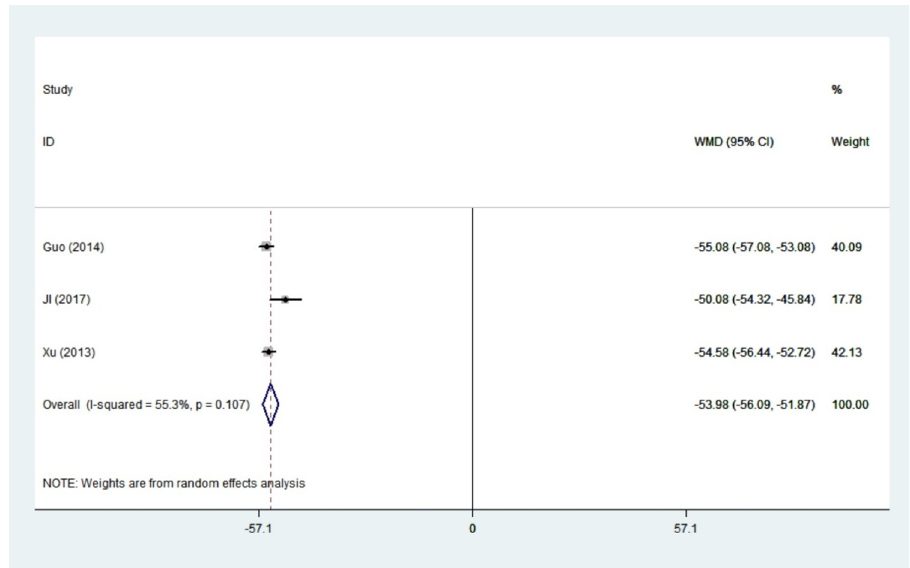
Fig 8. Forest plots of showing the effects of PTU on FT4.